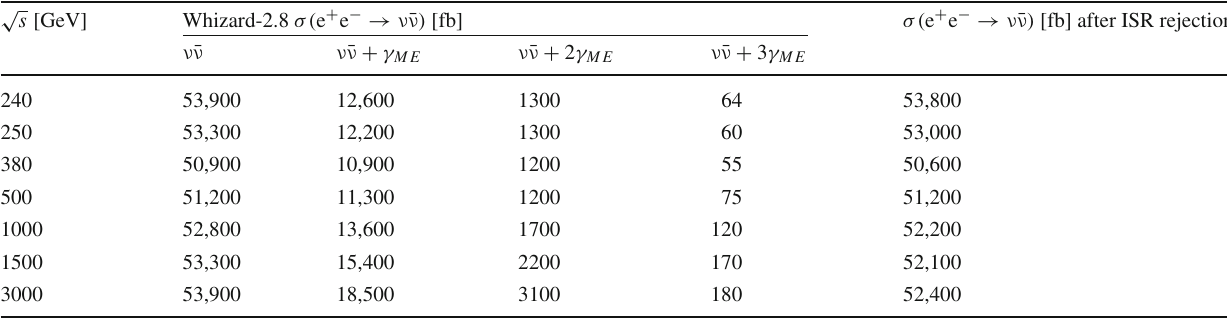
Table 1 Cross section values for (radiative) ν ¯ ν events with different collision energies and different multiplicities of photons included in the matrix element calculations. Number of significant digits indicates the statistical precision resulting from Whizard integration √